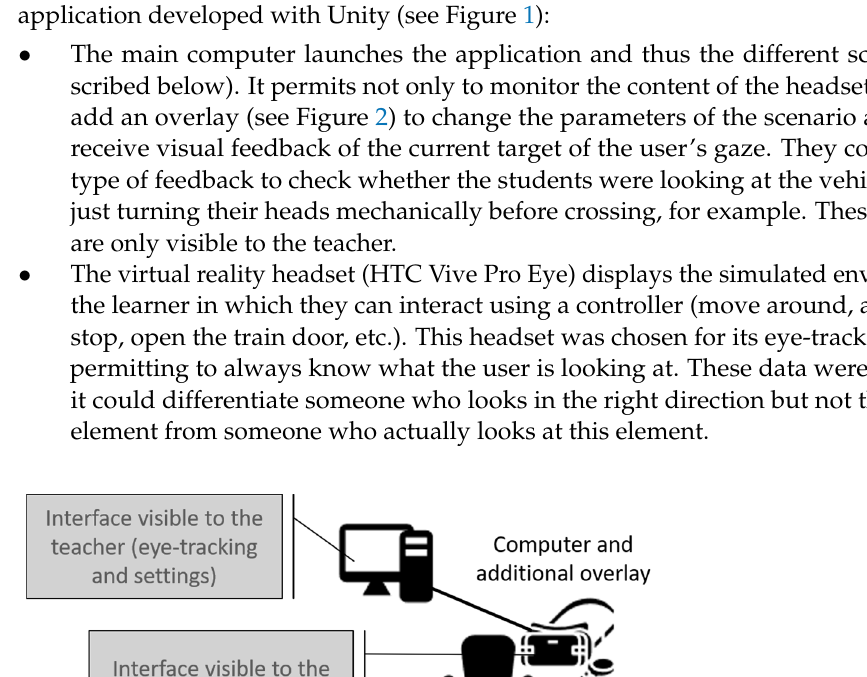
Figure 2. Overlay example for one scenario (with drivers’ kindness, minimum waiting time, maxi- mum waiting time, minimum time before next vehicle, vehicle speed, travel speed, day/night, and sunny/cloudy/rainy). The application architecture is composed of a base layer common to all sce- narios. This layer includes the following. The application architecture is composed of a base layer common to all scenarios. This layer contains:  The system of movement and interaction in VR. 